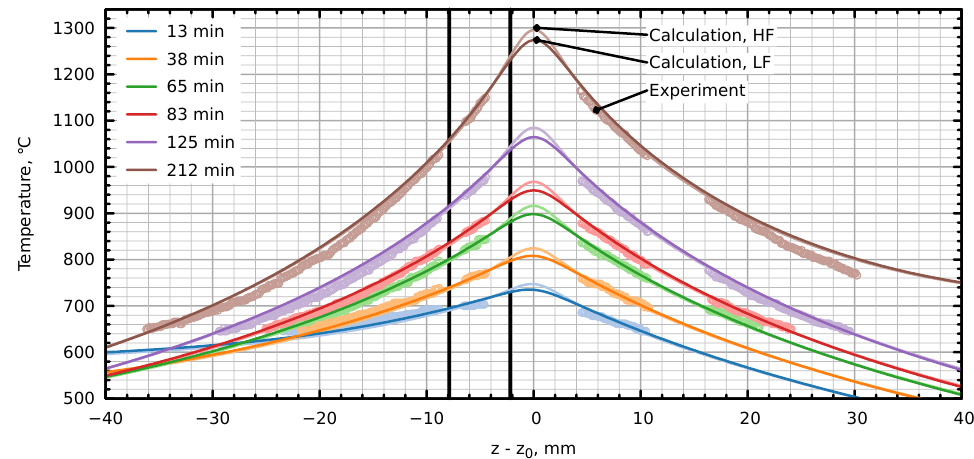
Figure 4. Comparison of vertical temperature distribution at different times with experimental measurements. Black vertical lines show the lower and the upper boundary of the measurement region. T ( z − z 0 ) distribution at t = 125min was symmetric with respect to the inductor, which allowed to obtain more precise measurement point coordinates.